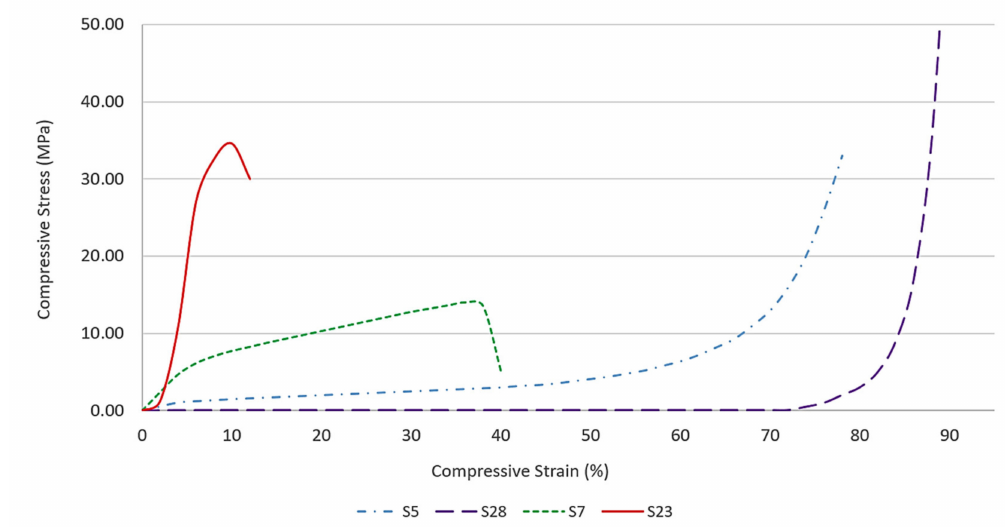
Figure 14. Stress-strain curves of sample S5 (semi-ductile), S28 (ductile), S7 (semi-brittle), and S23